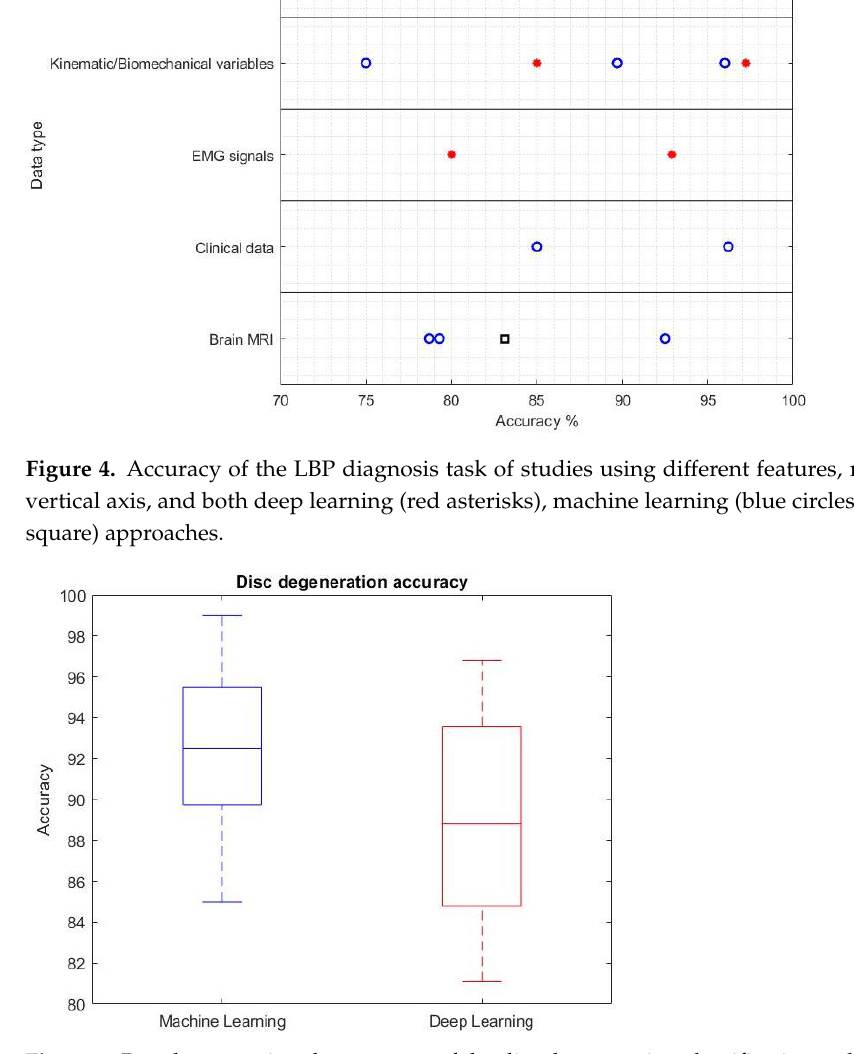
Figure 5. Boxplot reporting the accuracy of the disc degeneration classification task of studies that used machine learning ( left ) or deep learning ( right )